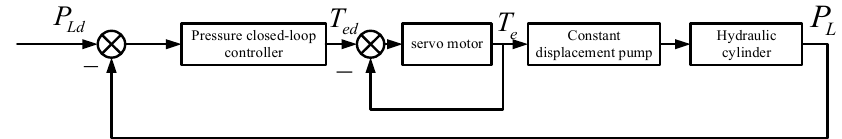
Figure 2. Schematic diagram of torque control pressure.